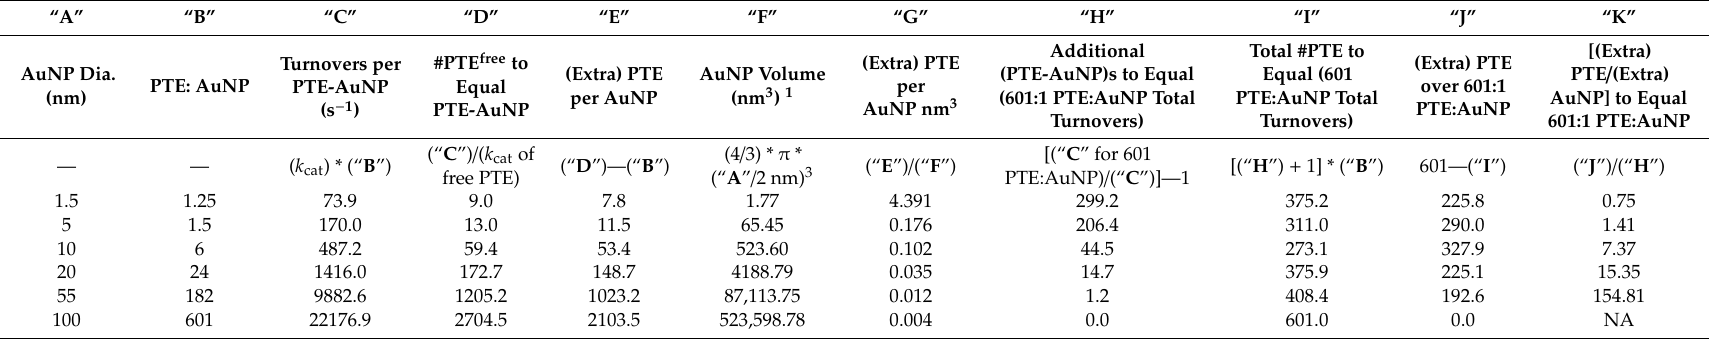
Calculations for Table 5, based on data from Breger et al. First row denotes columns for reference. Second row denotes column titles. Third row denotes calculations. 1 Based on nominal diameters (similar to those by TEM). “AuNP dia. (nm)” is the nominal diameter of the AuNP. “PTE:AuNP” is the approximate ratio of PTE to AuNP; “Turnovers per PTE-AuNP (s − 1 )”